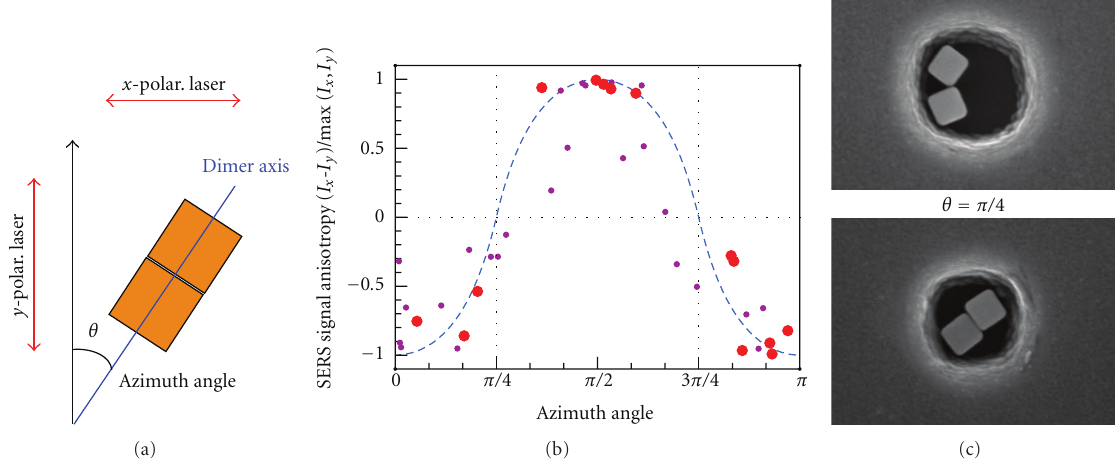
Figure 4: (a) Schematic of the azimuth angle θ between the positive y -axis and the dimer axis, traced clockwise. (b) The dependence of the SERS signal on the orientation of the polarization of the laser with respect to the orientation of the axis of the dimer of silver nanocubes. The SERS signal anisotropy is calculated as ( I x ( θ ) − I y ( θ )) / max( I x , I y ) (see definitions in text). The theoretical relation (sin 2 θ − cos 2 θ ) / max(sin 2 θ ,cos 2 θ ) is indicated by the blue dashed line. Data from dimers with SSEF > 10 5 (large circles) is closer to the theoretical trend than data from dimers with SSEF < 10 5 (small circles). (c) Examples of two dimers of silver nanocubes, oriented at θ = 0 and θ = π/ 4, respectively. The nanocube size is 85 nm. Each dimer is located inside a